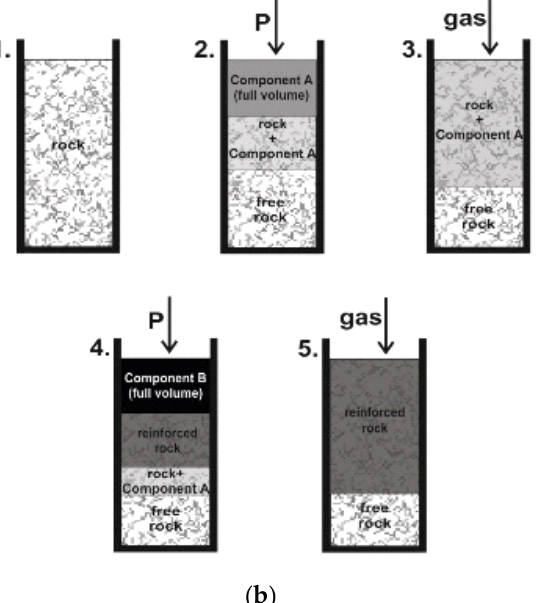
Figure 4. Sand rock reinforcement by the stepwise injection of the components A and B of the two- component silicate resin with their extrusion by gas into the rock between the injection stages: 1 — a placement of the rock in the test chamber of the laboratory stand; 2 — the injection of the full volume ( b ) or the small volume portions ( a ) of the compo nent A, “P” stands for injection pressure. A number of substages (2.1, 2.2…2.5) are representing the step -by-step injection of the component A portions ( a ); 3 — the extrusion of the component A of the resin solution with the compressed gas (nitrogen); 4 — the injection of the full volume ( b ) or the portions of the component B ( a ). A step-by-step injection (4.1, 4.2…4.5) of the component B portions ( a ); stage 5 — the extrusion of the component B of the resin solution with nitrogen.